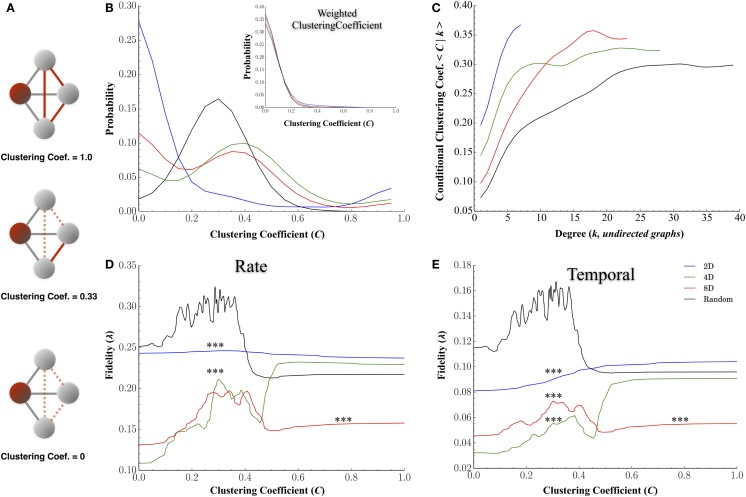
Clustering coefficients influence transmission fidelity. Clustering coefficient was computed from undirected graphs and is a measure of the cliquishness of a nodes surrounding connectivity and is a property known to affect the efficiency of communication. (A) Example of clustering coefficient calculation for the red shaded node i. Gray edges are connections from node i to three other neighboring nodes in gray, and dotted red edges are for unused possible connections. The clustering coefficient is a probability represented by the number of edges connecting neighbors of node i shown in red, divided by the total number of possible edges between neighbors of node i, shown in gray, of neighbors fully connected among themselves. (B) Distribution of clustering coefficients among nodes for each topology and (C) association between clustering coefficients and node degree (node degree among undirected graphs). (D,E) represent the association between a node’s clustering coefficient and transmission fidelity at rate and temporal scales with nodes it shares a functional connection with.